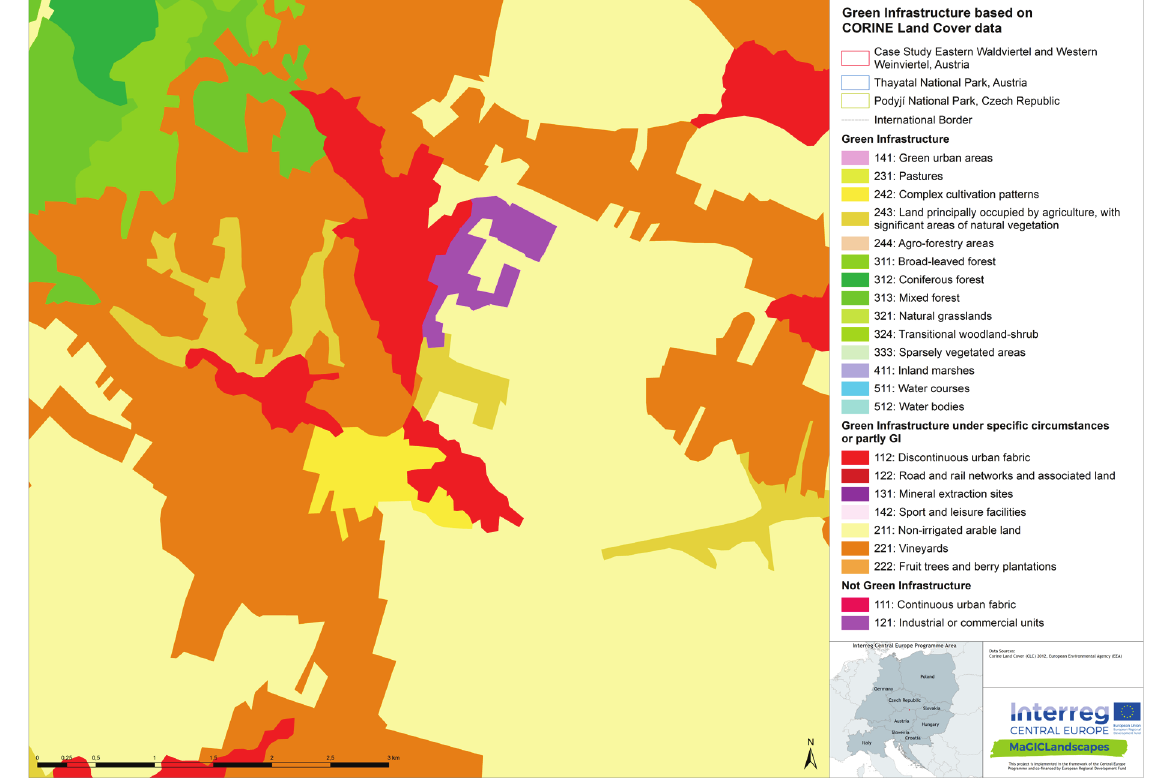
Figure 4. Exemplary detail section map of Green Infrastructure based on CORINE Land Cover data